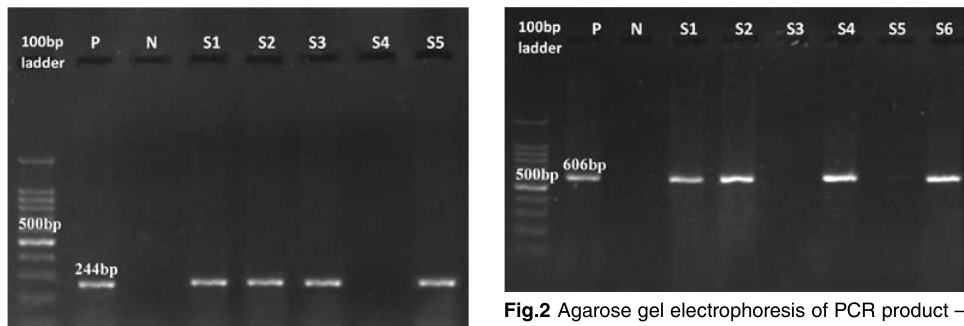
Fig.2 Agarose gel electrophoresis of PCR product